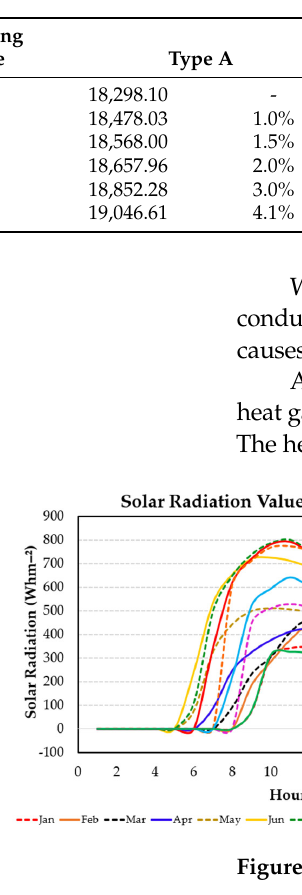
Table 10. Heat gains by conduction for Antalya.